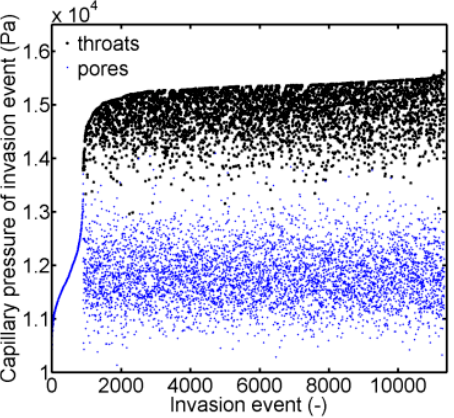
Figure 7. Capillary pressure curves of the drainage invasion process initiated in all surface pores.